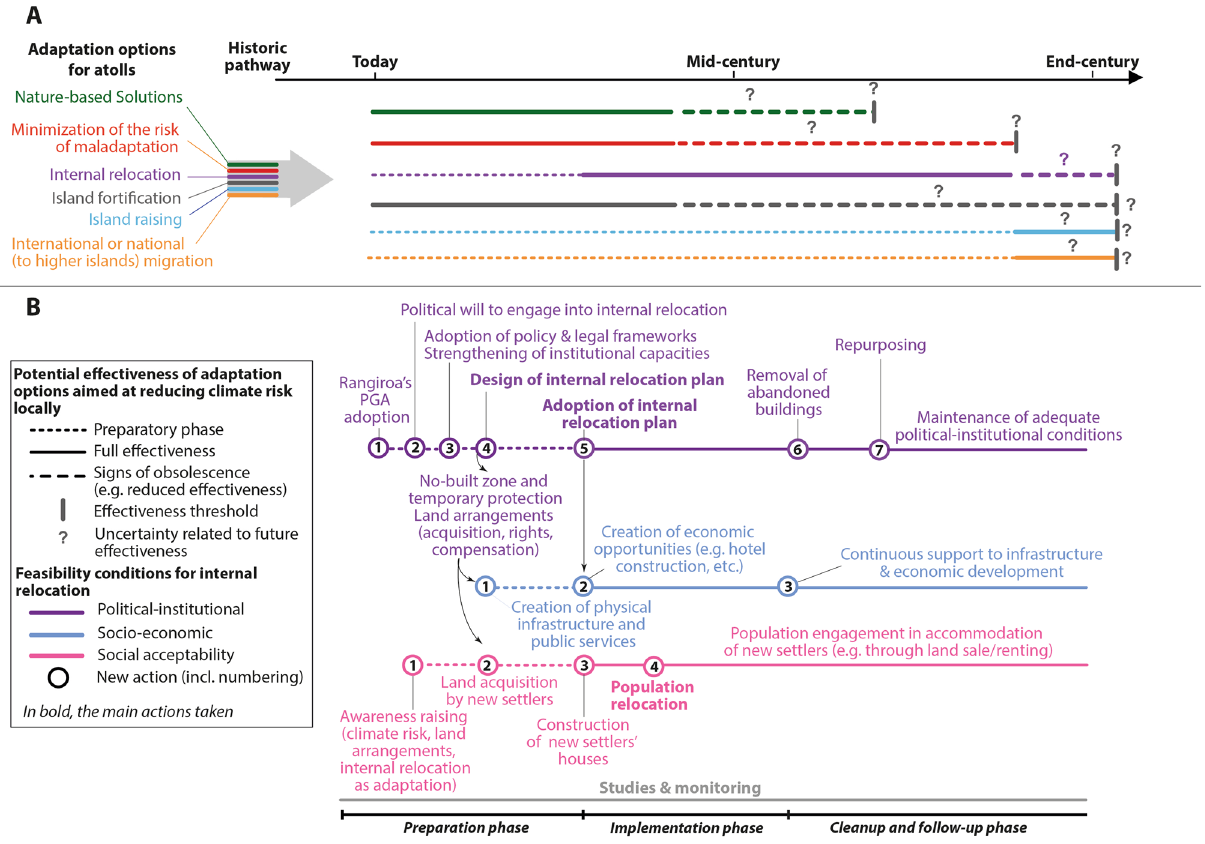
Figure 6. An internal relocation-oriented adaptation pathway for Rangiroa Atoll, French Polynesi a (inspired by Refs. 25,70,71 ). ( A ) presents an adaptation pathway for atolls that considers the six available adaptation options. It proposes a sequencing of adaptation options considering short-term options that allow to buy time (including Nature-based Solutions, minimization of the risk of maladaptation, and island fortification using engineered protection structures along shorelines) until the public authorities are ready to implement a long-term internal relocation plan. Island raising (still highly uncertain from a technical perspective because atoll island substratum is highly permeable) and/or out-migration (to higher islands in French Polynesia in the case of Rangiroa) are considered last resort adaptation options. ( B ) details the sequence of actions that are needed to implement internal (i.e. within-atoll)